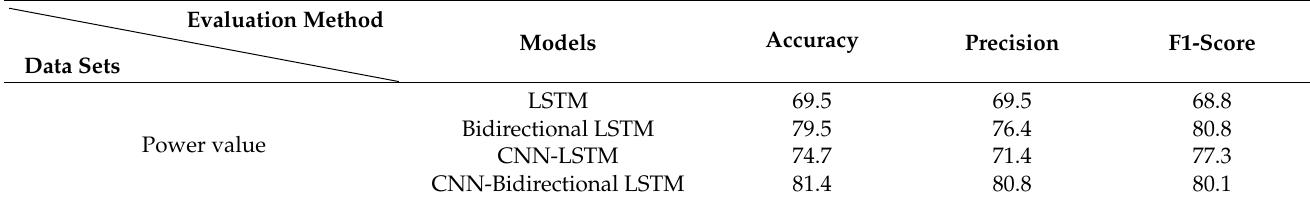
Table 5. DL models’ accuracy, precision, and F1-score based on power values.